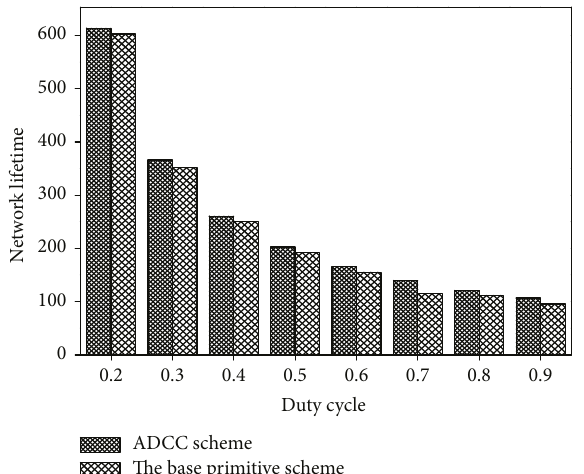
Figure 18: The network lifetime of network with di ff erent duty cycles.